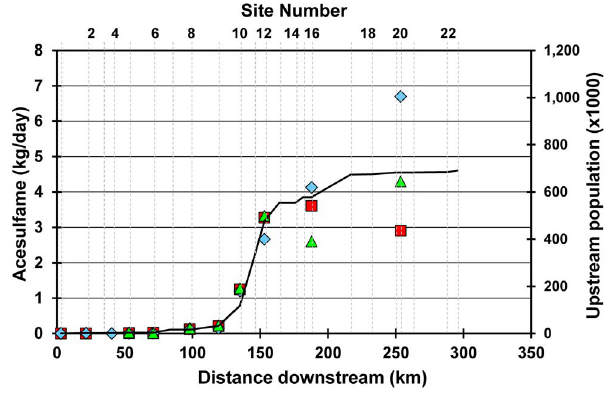
Figure 4. Mass flux of acesulfame in the Grand River . Daily mass flux of acesulfame at gauged sites for each sampling date; Jun 2007 (blue diamonds), Sep 2007 (red squares), Apr 2009 (green triangles). Cumulative population contributing to WWTP discharge upstream of each site is indicated by the black line.